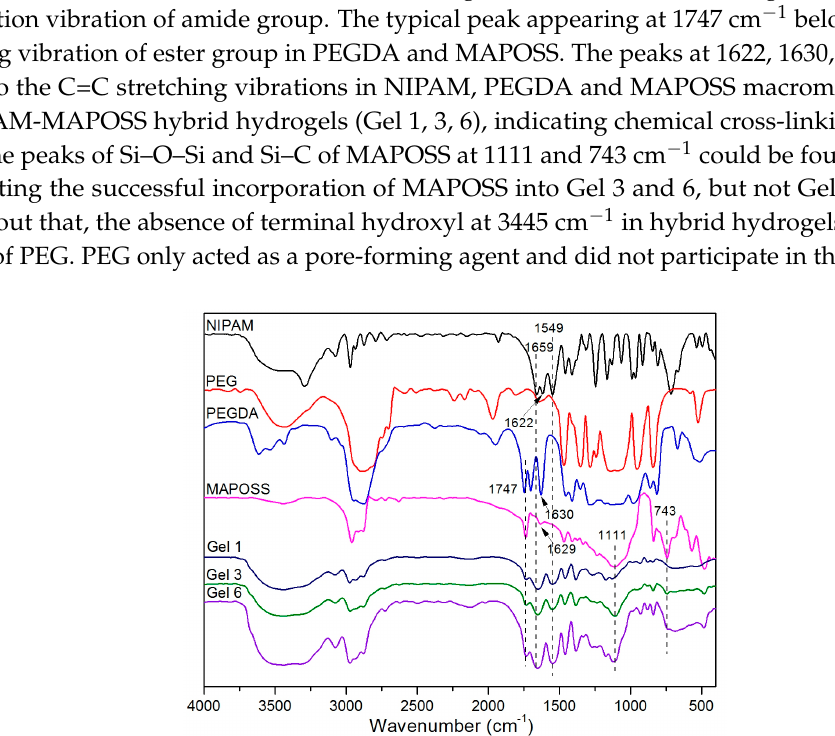
Figure 2. FTIR spectra of NIPAM, PEG, PEGDA, MAPOSS, and PNIPAM-MAPOSS hybrid hydrogels.